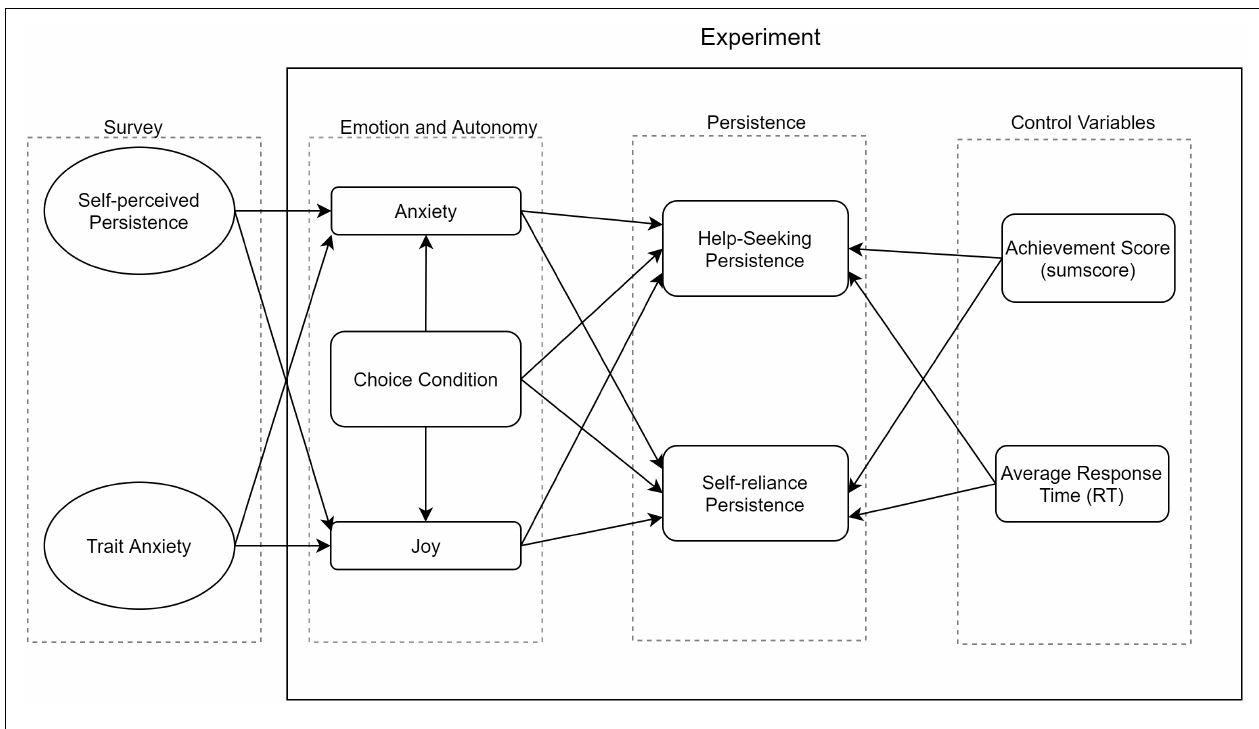
FIGURE 2 | Proposed structural equation modeling analysis model.